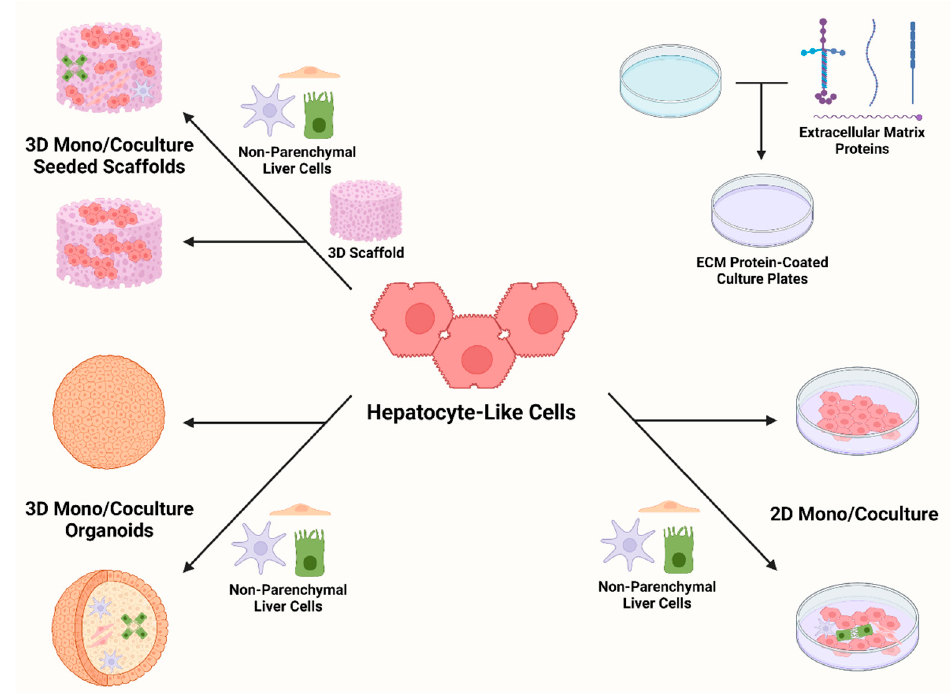
Figure 2. Methods of culturing iPSC-derived hepatocyte-like cells.